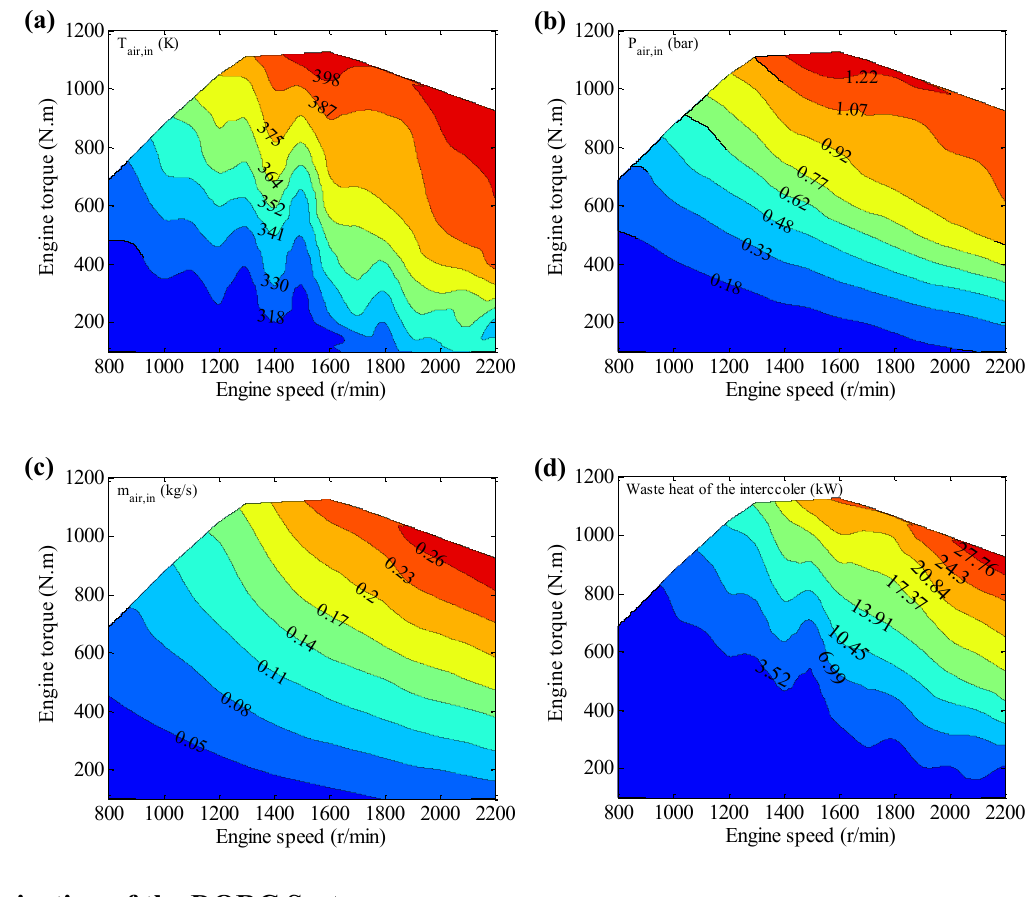
Figure 7. ( a ) The intake air temperature in the preheater; ( b ) The intake air pressure in the preheater; ( c ) The intake air mass flow rate in the preheater; ( d ) The intake air waste heat flow rate in the